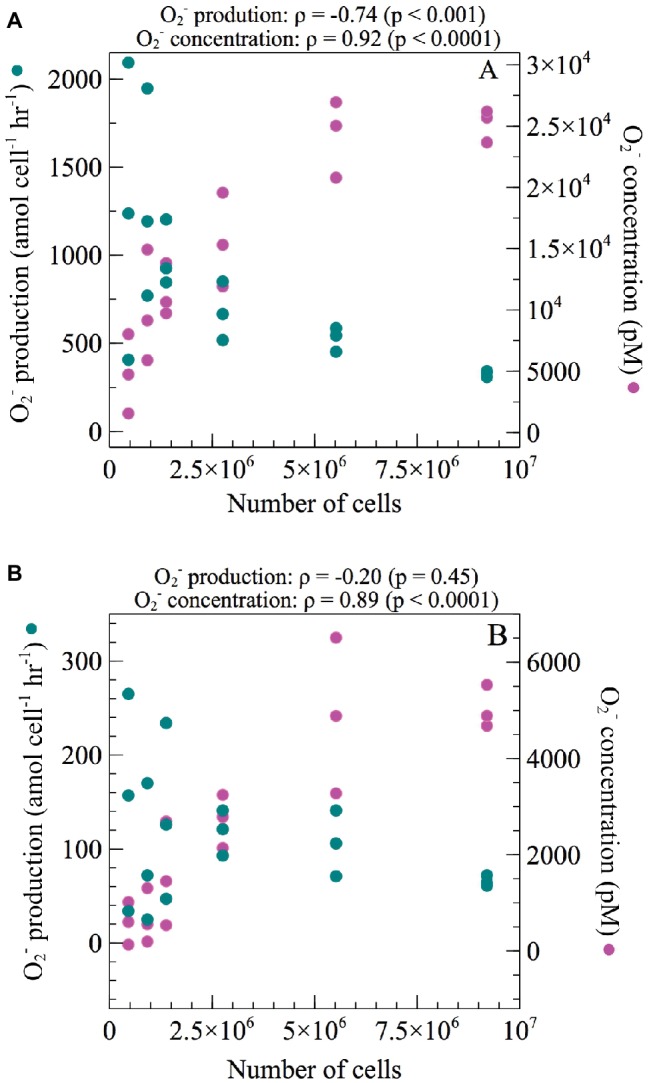
Net per-cell O2− production rates and total steady-state O2− concentrations were measured across a range of increasing cell numbers during (A) exponential and (B) stationary growth phases of E. huxleyi. Regression analysis was performed using Spearman’s rank-order correlation. Correlation coefficients (ρ) and their level of significance (p) are provided.